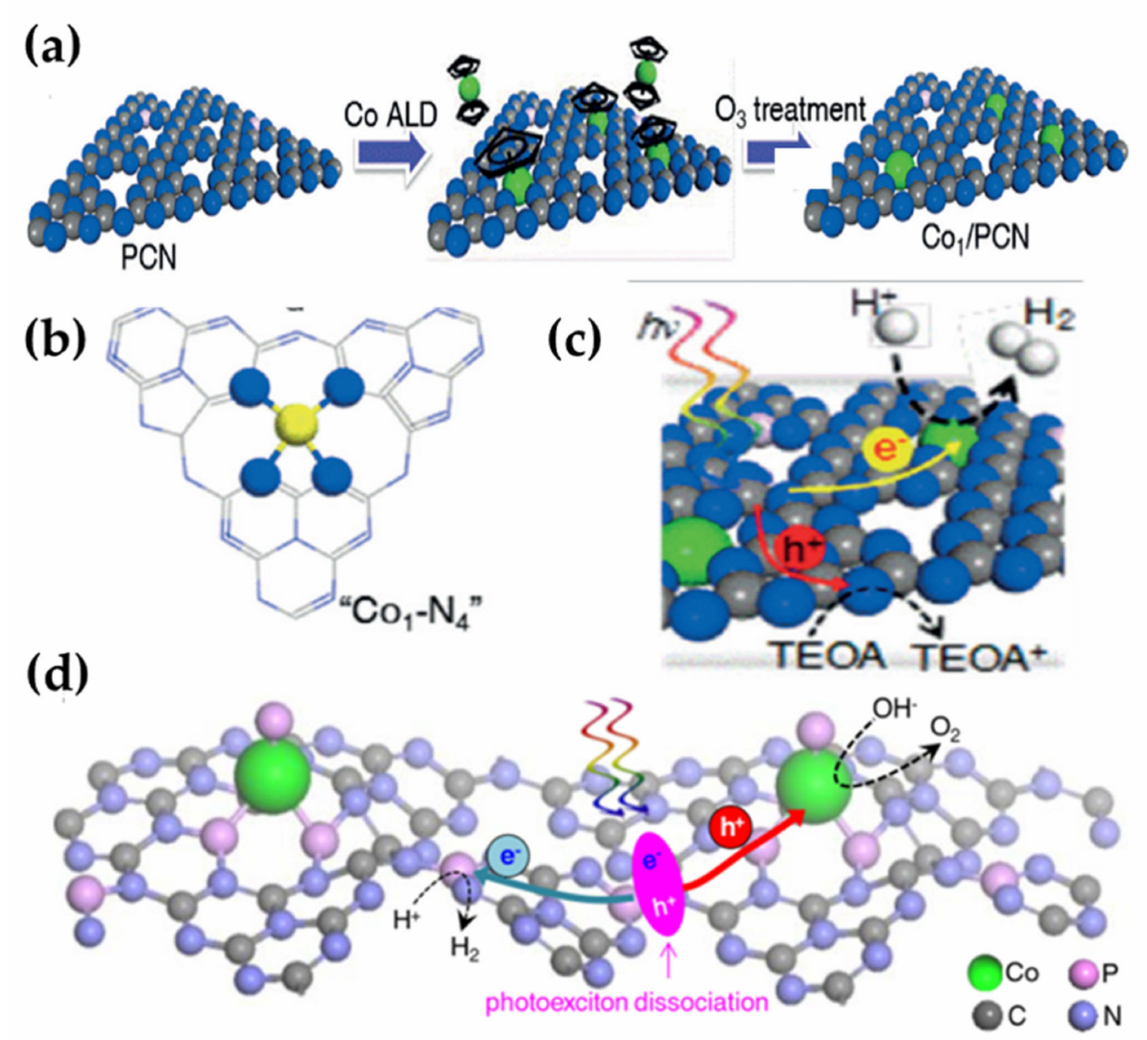
Figure 10. ( a ) Illustration of the synthesis for a single-site Co 1 /PCN catalyst by the ALD method [111]; ( b ) Top view of the model structures: “Co 1 -N 4 ” [111]; ( c ) Illustration of photocatalytic H 2 production of Co 1 /PCN [111]; ( d ) Schematic illustration of the solar-driven overall water splitting on Co 1 -phosphide/PC 3 N 4 photocatalyst, where the photogenerated electrons and holes are spatially separated and transferred to active sites to drive HER and OER